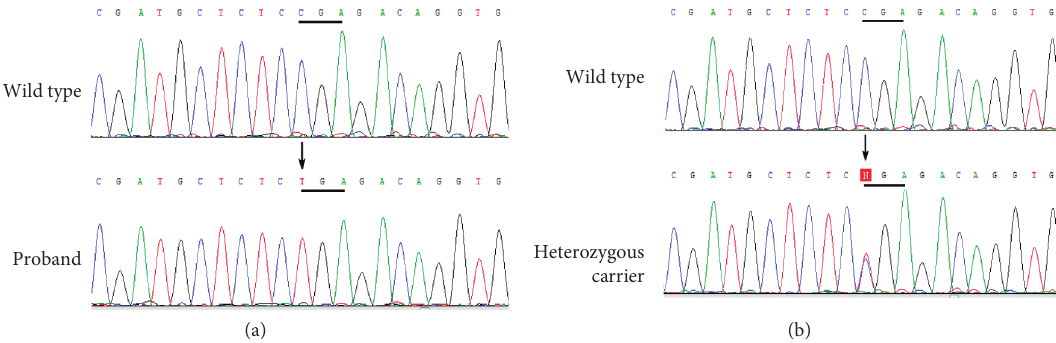
Figure 3: Genetic analysis of the SLCO2A1 gene. (a) The homozygous mutation, c.1807C > T/p.R603 ∗ , in the proband (V-4). (b) The heterozygous mutation, c.1807C > T in III-1, III-4, IV-2, IV-3, IV-4, and V-4.